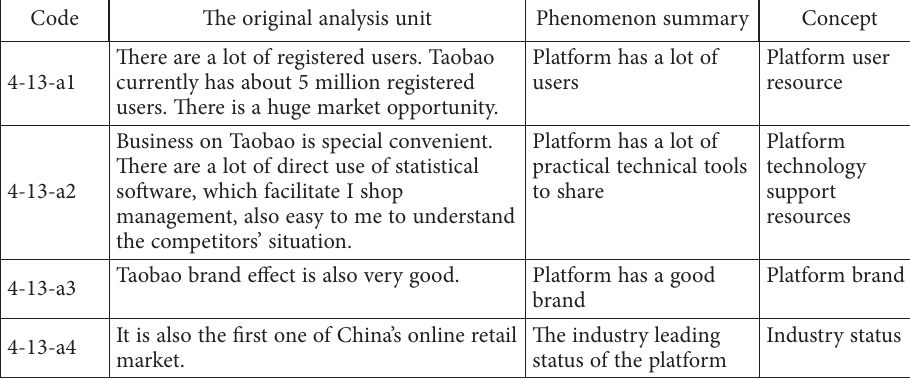
Table 1. Example of the concept of open encoding (original data are derived from 13th samples’ answer to the 4th question)